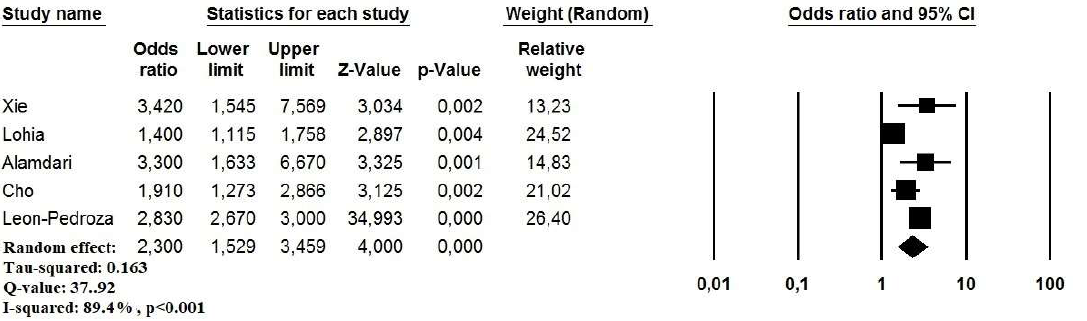
Figure 4. Forest plot investigating the mortality risk due to metabolic syndrome in COVID-19 patients using a random- effect model.